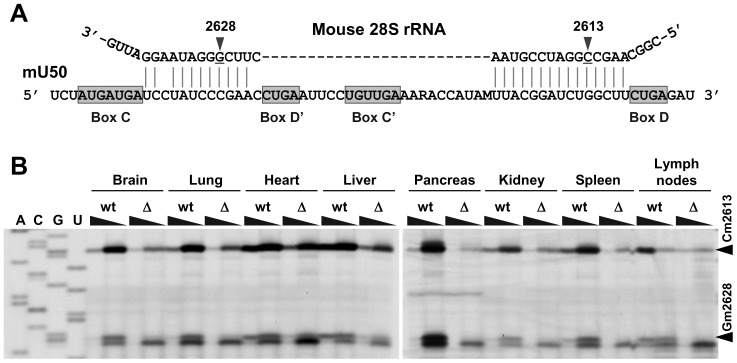
Mechanism of action of mU50 snoRNA.(A) Schematic representation of mU50 snoRNA binding to 28S rRNA. The mU50 snoRNA sequence contains two sites that are complementary to two methylation-target sites in the 28S rRNA sequence. Consensus C and D (and C’ and D’) box motifs are shown in shaded rectangles. The ribonucleotides that are located 5 bases prior to boxes D and D’ (indicated by the arrows) are methylated. (B) Methylation-sensitive primer extension assay for U50-sites in various mouse organs. The wedges across every two lanes indicate the concentration of dNTP (1 mM and 0.004 mM) in the reaction mix. The reverse transcriptase generates a stop signal one nucleotide before the 2′-O-methylated nucleotide in the presence of 0.004 mM dNTP. The upper and lower arrows on the right of the Figure indicate the Cm2613 and Gm2628 stop signals on 28S rRNA, respectively. wt: wild-type; Δ: ΔmU50(HG-b) mice.